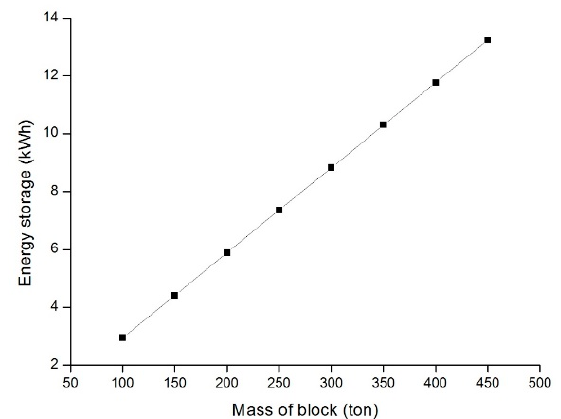
Figure 4. The effect on energy storage potential as a function of the amount of mass of the block.